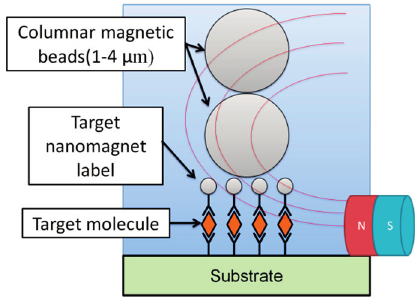
Figure 3. Our concept for a simple method to detect nano-sized magnetic particles via magnetically captured micro-sized magnetic particles using an optical microscope. Adapted from [8].